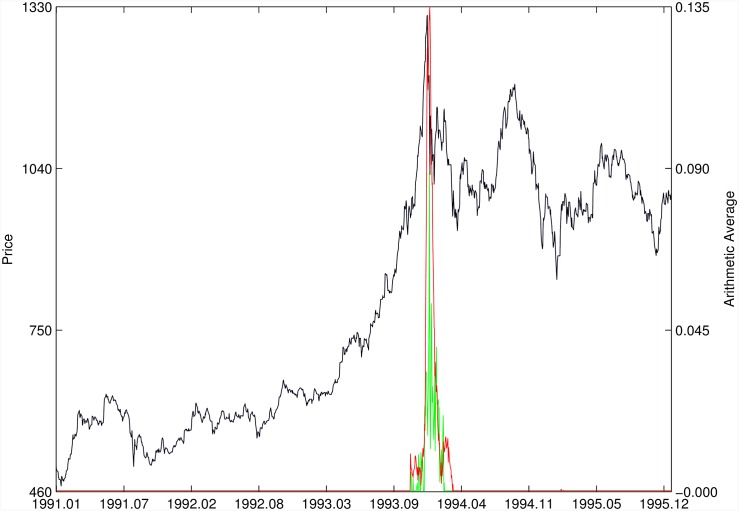
Malaysia 1994.Same as Fig 10.